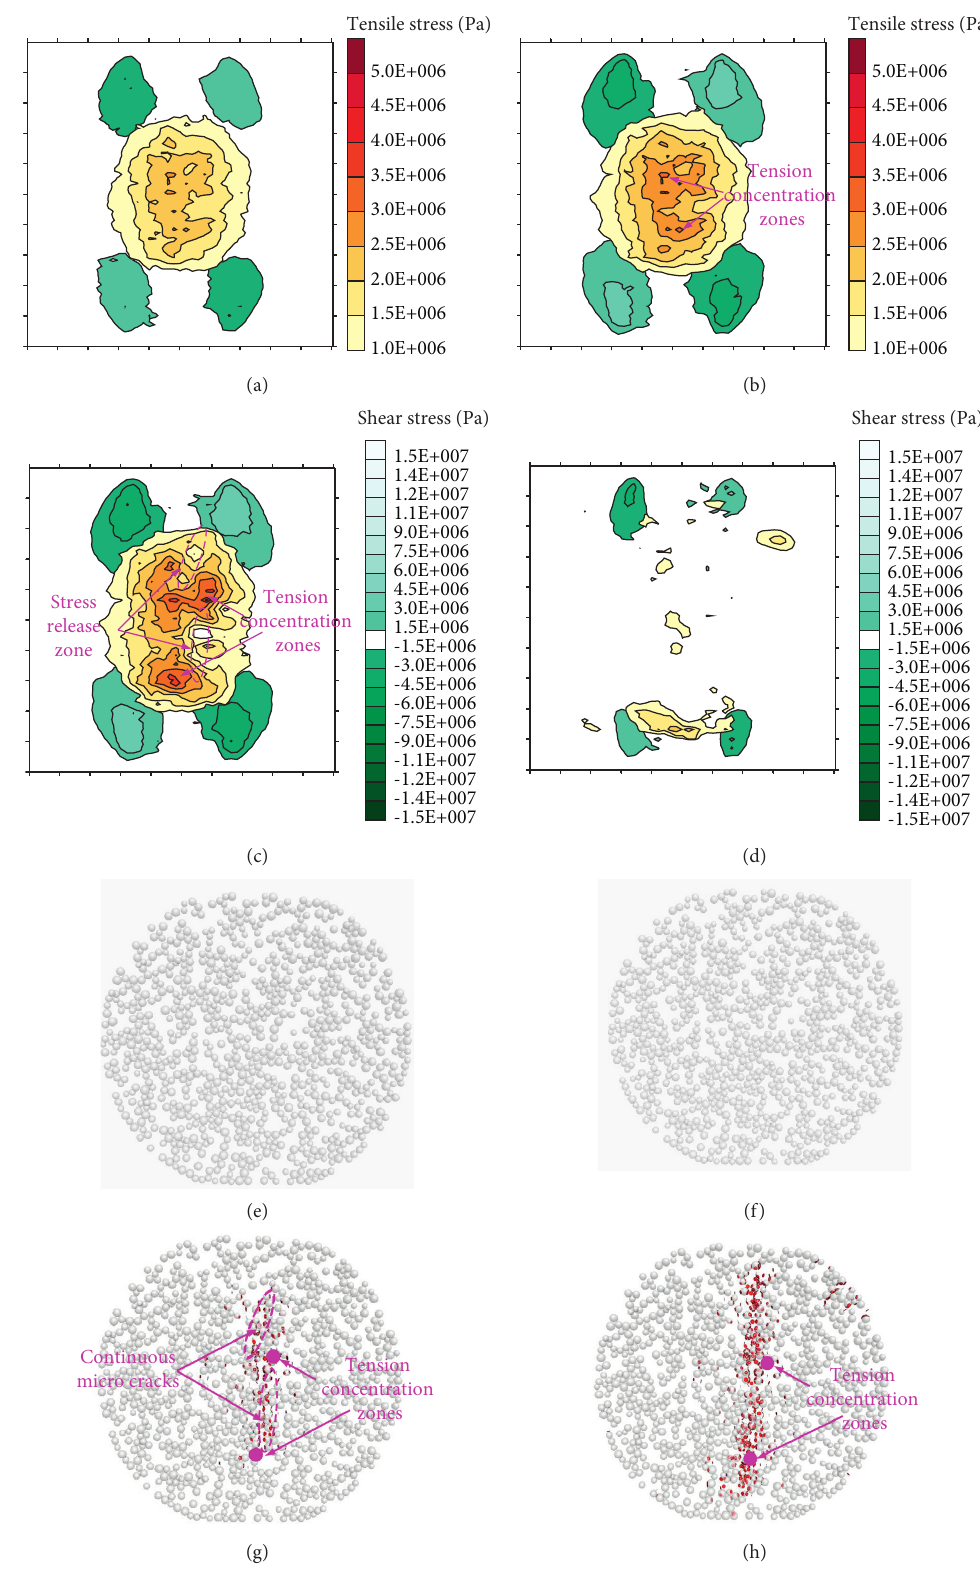
Figure 16: Stress conditions and crack propagations at the monitor points on the vertical ABC plane for the FBT tests (15 ° ): (a–d) stress conditions; (e–h) crack